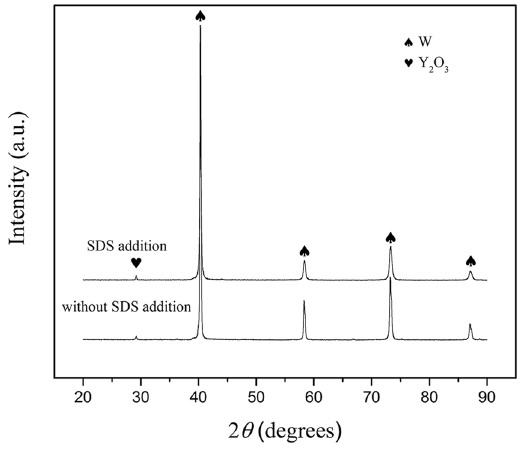
Figure 1. XRD patterns of the W-Y 2 O 3 composite powder precursors fabricated by traditional and improved wet chemical method.